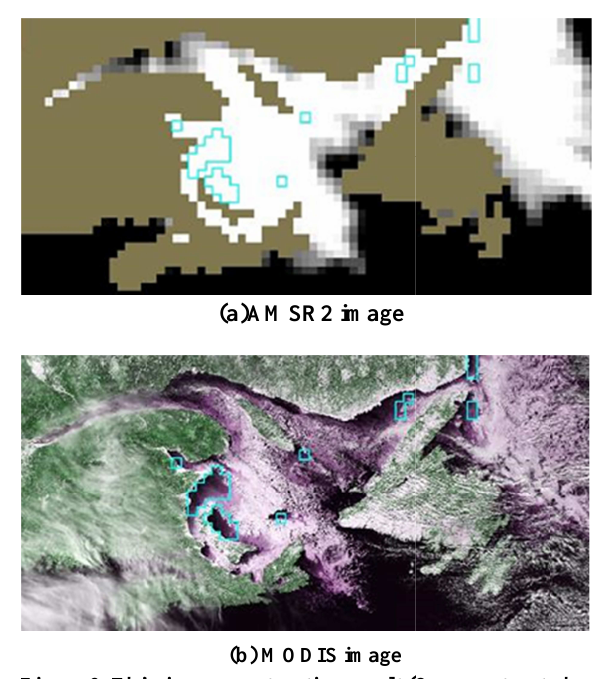
Figure 9 . Thin ice area extraction result (Cyan: